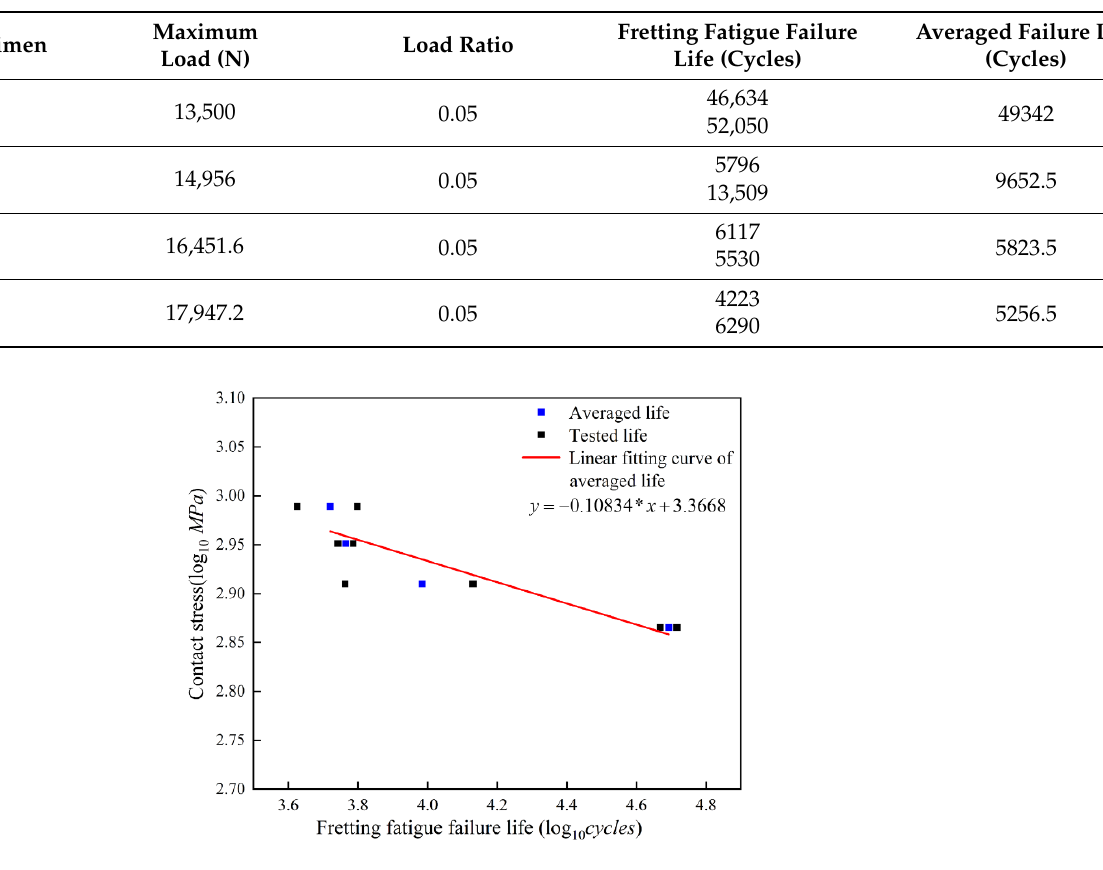
Table 7. Fretting fatigue failure life of DD10 dovetail specimen.